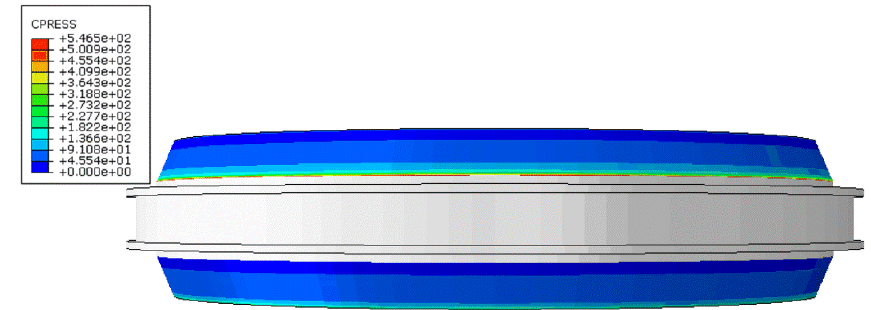
Figure 10. The contact stress distribution of the VX gasket after optimization.